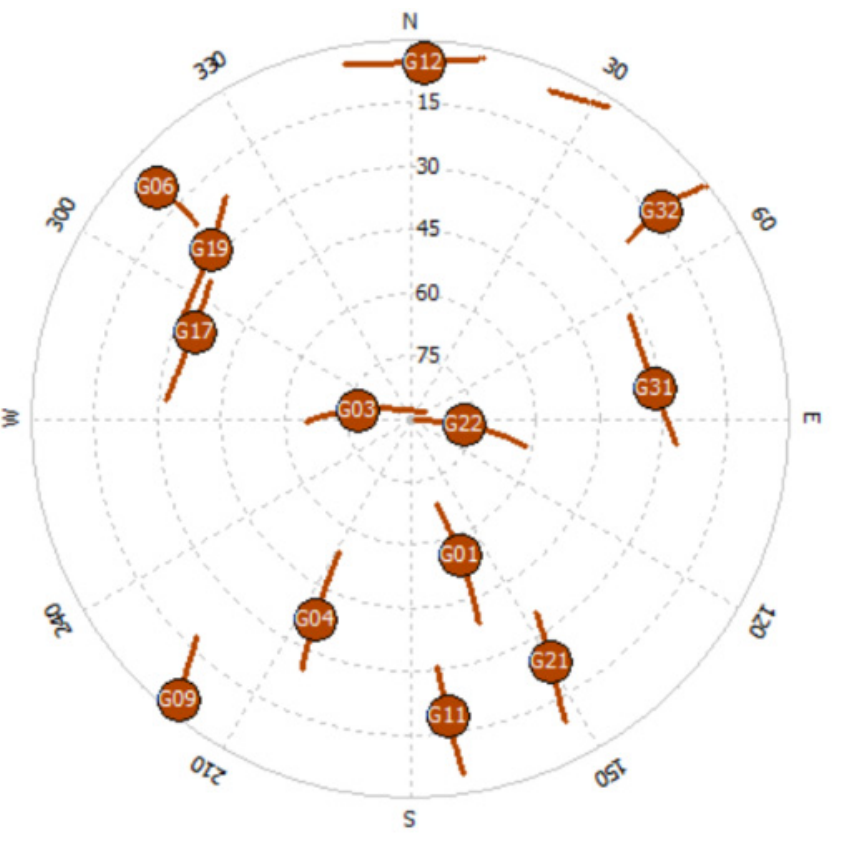
Figure 4. Skyplot of the GPS satellites during the experiment. Table 1. Average RMS errors for EGNOS and SDCM positioning, and C1C and C1W codes.